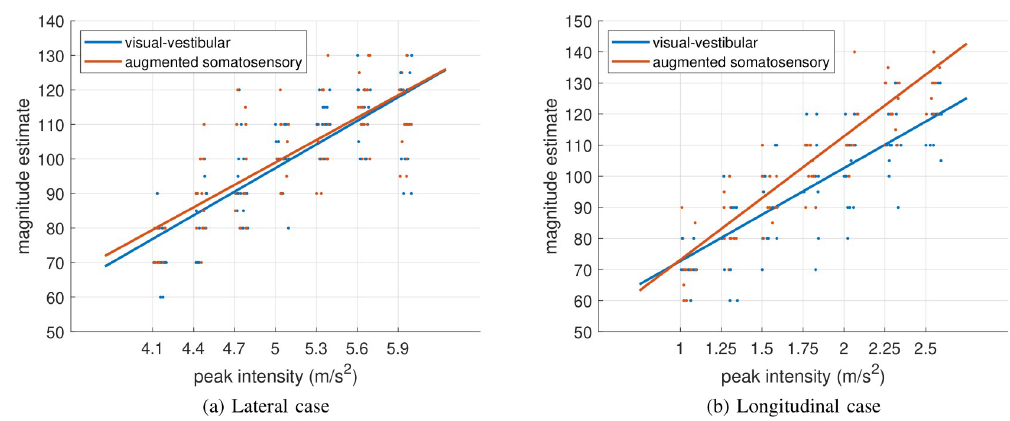
Fig 5. Data acquired in the ME task for the cornering (left panel, (a)) and brake maneuver (right panel, (b)) cases. Light blue and orange dots represent individual responses collected in the M and S conditions, respectively. A small amount of random noise was added to the x-coordinate of individual data points to improve their visibility. Lines are the four fitted psychometric functions obtained by model (1), which describe the four cases in which participants have been split, i.e. the braking and the cornering maneuver, both experienced with or without ASB active. The results suggest that the bladders of the ASB system do not increase perceived intensity in curves, but the belts do increase perceived intensity in braking maneuvers. No unit is provided for the y-axis as magnitude estimates are expressed on a subjective scale.